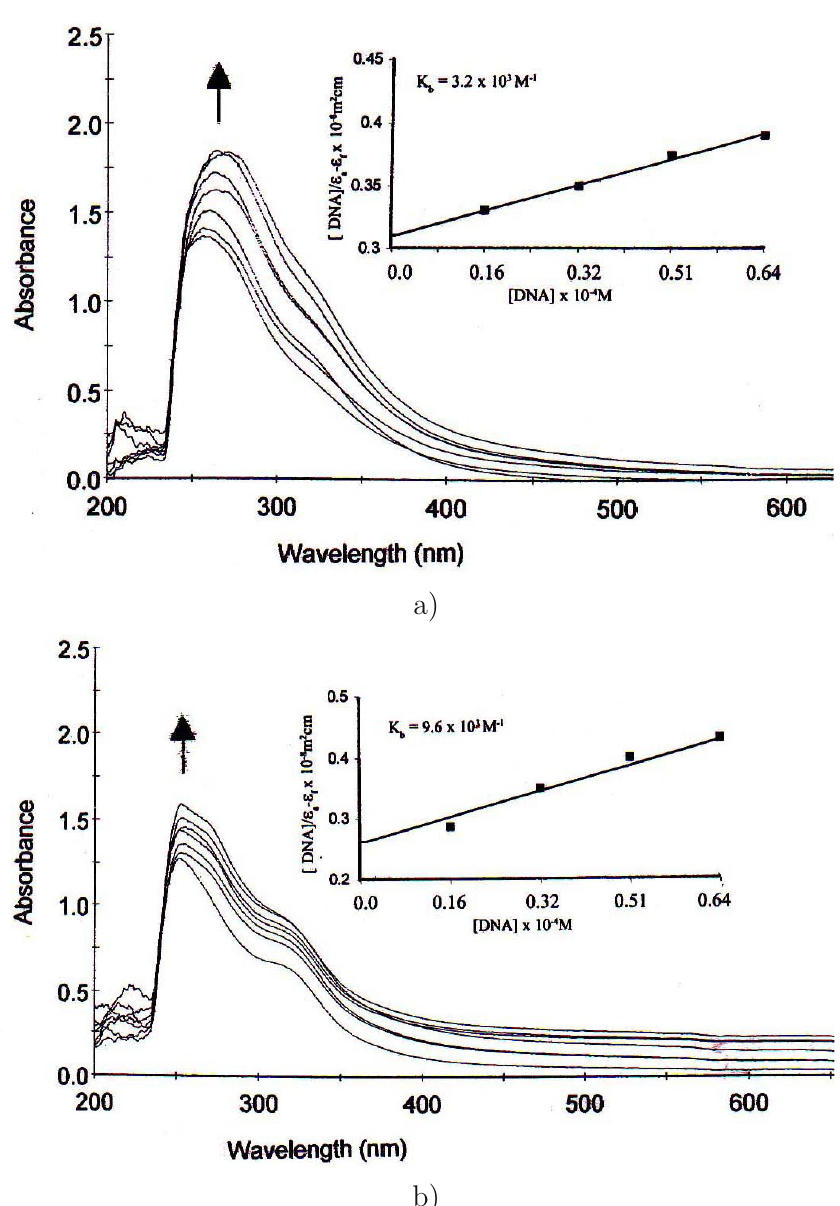
Fig. 3 Absorption spectral traces of (a) complex 1 (b) complex 5 in Tris HCl buffer (0.01 M, pH 7.5) upon addition of CT-DNA. Inset: Plots of [DNA]/ ε the titration of CT-DNA with complexes; (cid:2) : experimental data points, full lines: linear fitting of the data. [Complex] 1 . 6 × 10 − 5 M, [DNA] 1 . 6 − 6 . 4 × 10 − 5